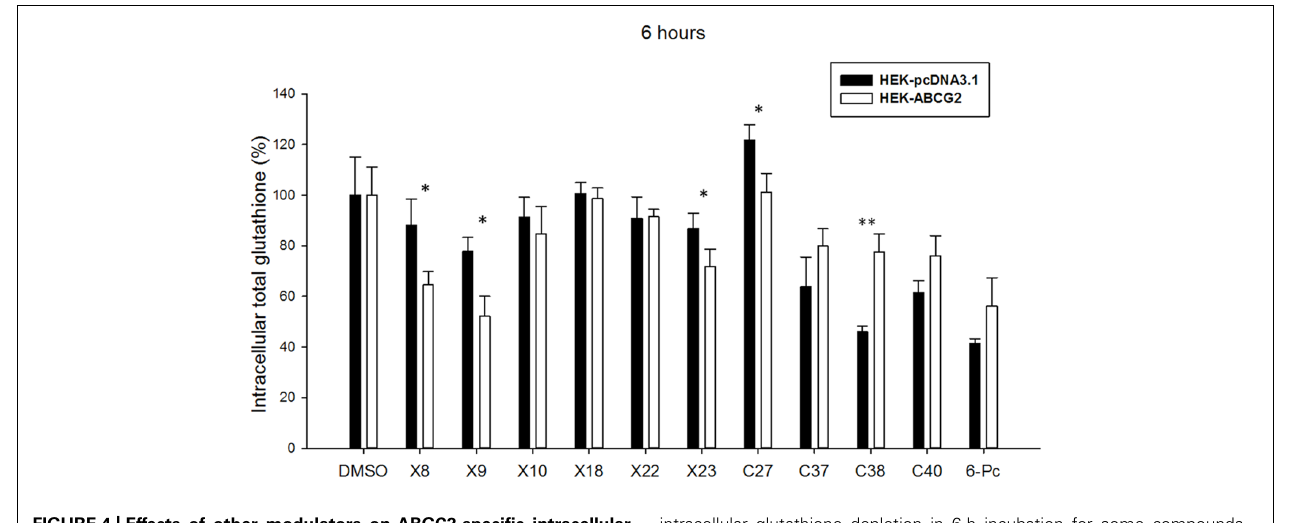
FIGURE 4 | Effects of other modulators on ABGC2-specific intracellular glutathione depletion. Screening of Xanthones (Genoux-Bastide etal., 2011), Chalcones (Valdameri etal., 2012), and 6-Prenylchrysin (Ahmed-Belkacem etal., 2005) reveal a significant ABCG2-dependent